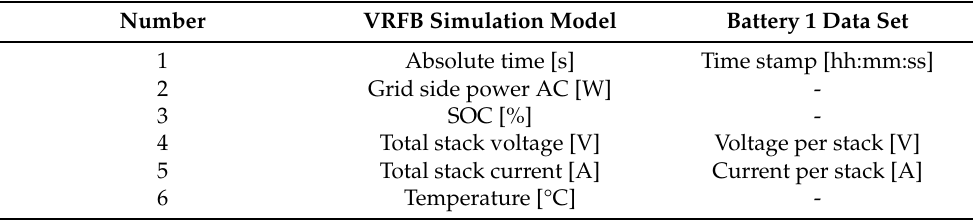
Table 2. Overview: Comparison of the preset parameters of the simulation